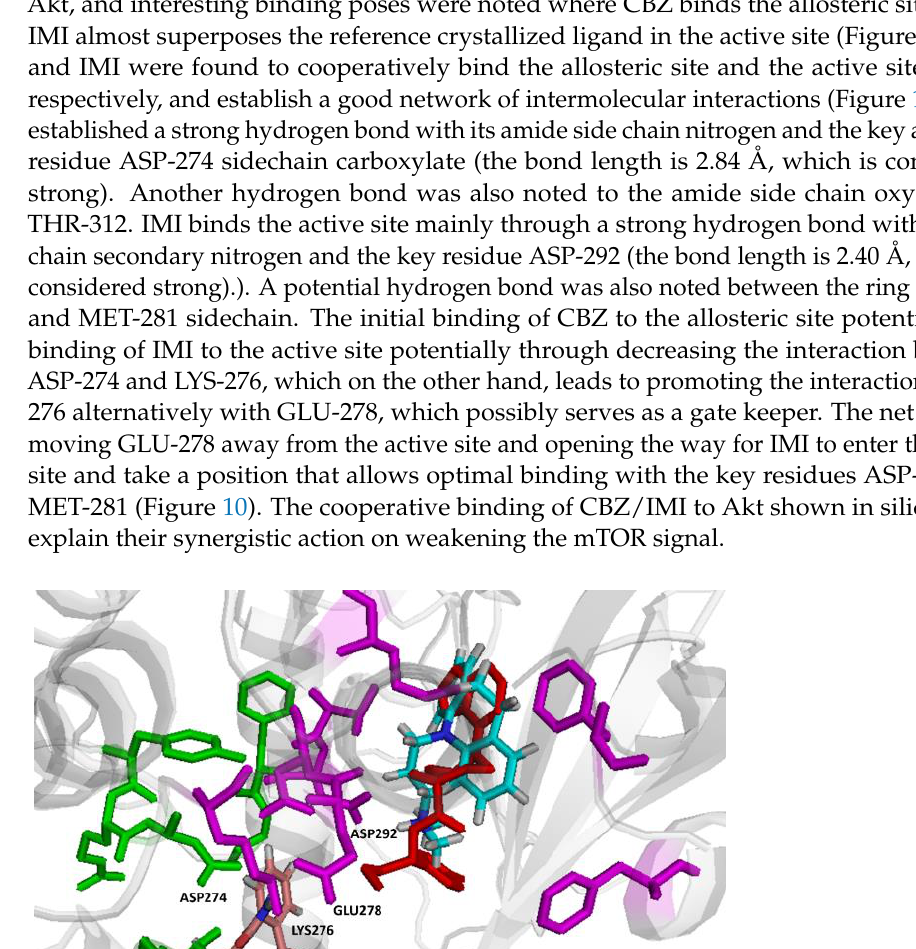
Table 1. Dockings scores for carbamazepine, imipramine alone and co-bound in Akt.